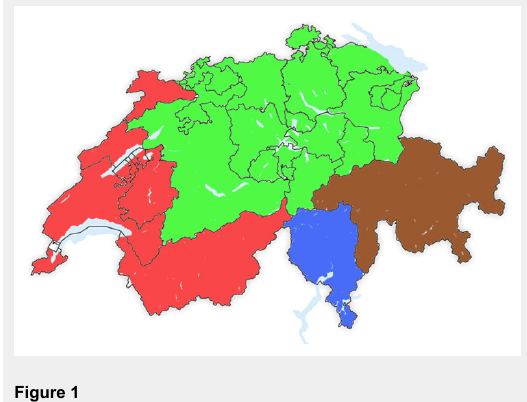
Distribution of Switzerland into four cultural / language groups (Green = German speaking, Red = French speaking, Blue = Italian speaking, Brown = Canton of Grisons / Romansh speaking